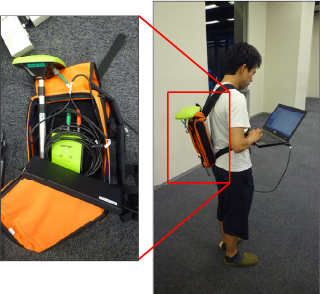
Figure 1. Position data acquisition in an indoor-outdoor environment Indoor navigation system